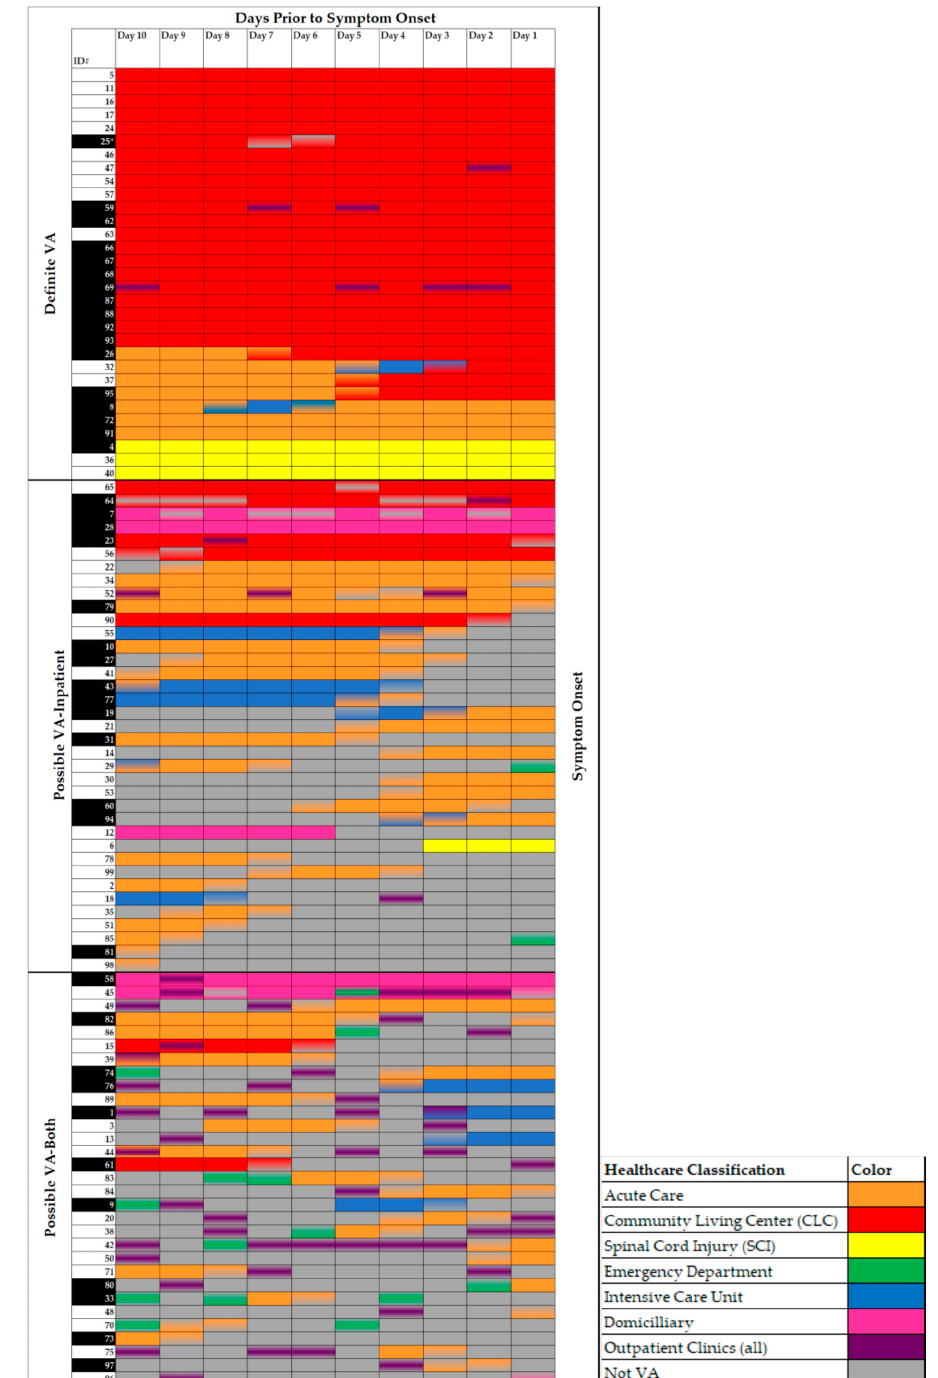
Figure 3. Location of healthcare-associated Legionella disease (LD) cases in the 10 days prior to symptom onset. Day 10 represents the first day at the beginning of the review period to determine whether or not the patient had exposure to the VA healthcare system. Patient movement within the healthcare system is depicted by showing clinic appointments as shading (purple) in the middle of the day and admission and discharge is shown as half-shaded days, allowing for visualization of all the points of the healthcare system the patient contacted during the 10-day period. Cases are arranged by classification type. Possible VA LD cases are arranged based on number of days of overnight stay exposure from highest to lowest. The asterisk for case 25 denotes a molecular match between clinical and environmental samples, resulting in the case being classified as definite VA LD despite the person leaving the CLC within the 10-day exposure window. Cases with the ID# shaded black with white writing denote LD case report forms that indicated the patient or resident had contact with a building that tested positive for Legionella during the quarterly water testing immediately prior to the occurrence of the